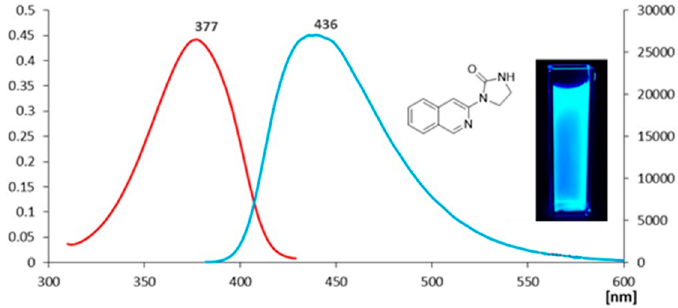
Figure 5 . Absorption and fluorescence spectra of 1-(isoquinolin-3-yl)imidazolidin-2-one ( 3e ).